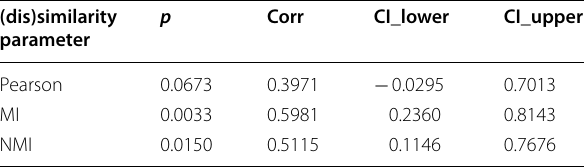
Data are displayed for similarity parameters giving significant correlation with the score values ( p < 0.05)